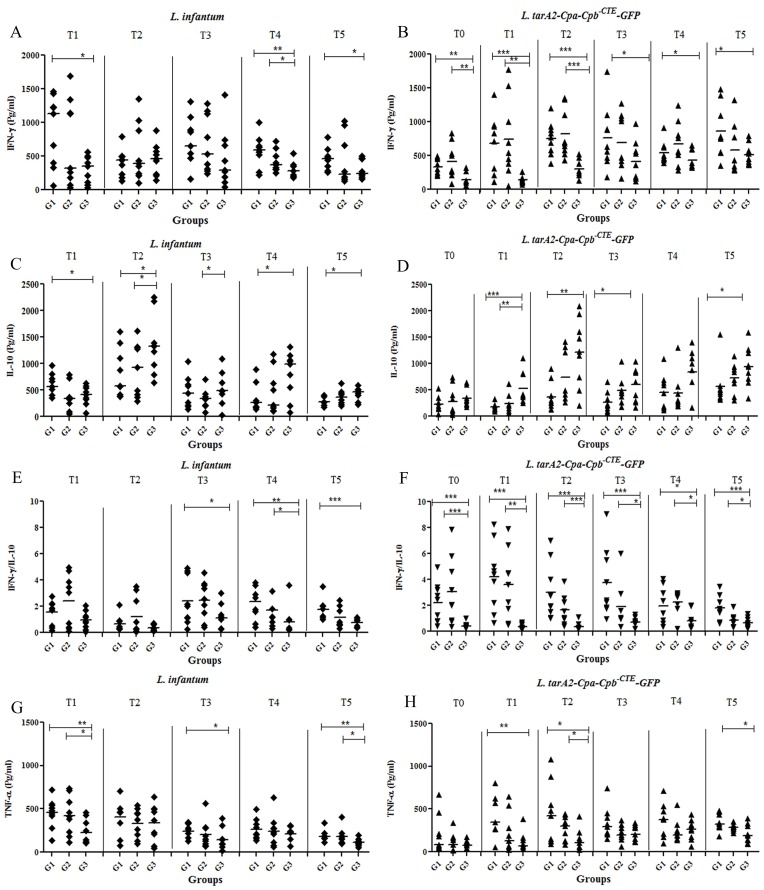
Assessment of IFN-γ, TNF-α and IL-10 levels in PBMCs.Panel (A) shows IFN-γ levels detected after challenge in PBMC culture supernatants stimulated with L. infantum (F/T) at different time points post-infection. Panel (B) shows levels of IFN-γ detected in PBMC culture supernatants produced in response to L. tarentolae A2-CPA-CPB-CTE-EGFP (F/T) before challenge and at different time points post-infection. Panel (C) shows the levels of IL-10 in response to L. infantum (F/T) at different time points after infection. Panel (D) shows levels of IL-10 in response to L. tarentolae A2-CPA-CPB-CTE-EGFP (F/T) before challenge and at different time points after infection. Panel (E) shows IFN-γ/IL-10 ratio in response to L. infantum (F/T) at different time points. Panel (F) shows IFN-γ/IL-10 ratio in response to L. tarentolae A2-CPA-CPB-CTE-EGFP (F/T) before challenge and at different time points after infection. Panel (G) shows levels of TNF-α in response to L. infantum (F/T) at different time points after infection. Panel (H) shows levels of TNF-α in response to L. tarentolae A2-CPA-CPB-CTE-EGFP (F/T) before and at different time points after infection. The asterisk indicates the significant difference between values at the indicated time points as determined by Student’s test (p< 0.05 denoted as *, p<0.01 denoted as **, p<0.001 denoted as *** and n.s. denoted as non significant).